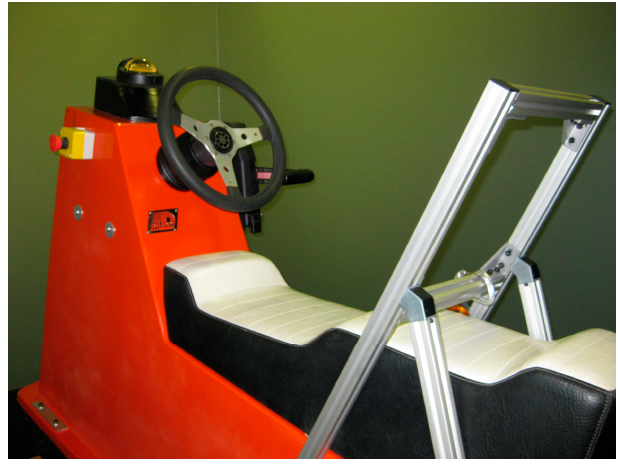
Figure 4. Example of vehicle controls for the speedboat simulator.